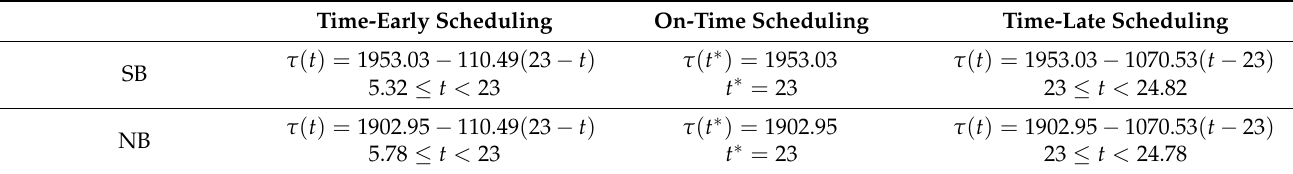
Table 8. Optimal non-queueing toll schemes for southbound (SB) & northbound (NB) ships. Time-Early Scheduling On-Time Scheduling Time-Late